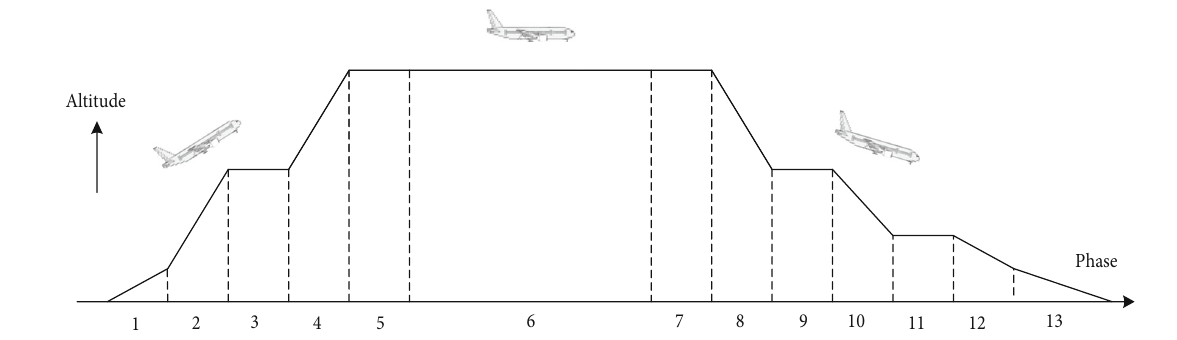
Figure 1: Flight behavior represented by fl ight phases for a typical civil